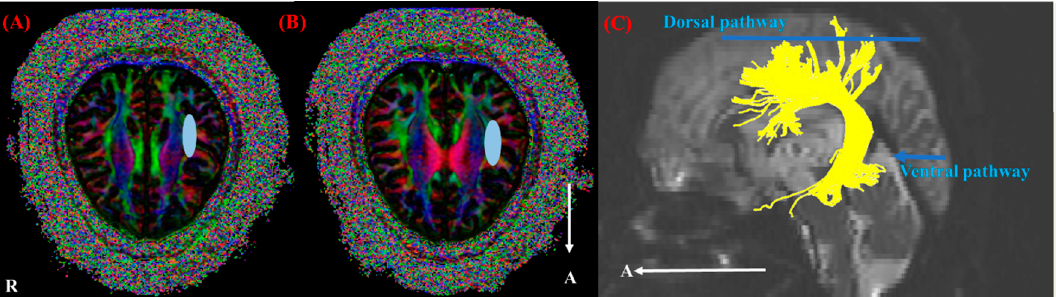
Figure 2. ( A ) “OR” region of interest (ROI) of the superior longitudinal fasciculus (SLF). ( B ) “AND” ROI of the SLF. ( C ) Reconstruction of the right SLF using diffusion tensor imaging (DTI) in a control subject (55 years, female). Note: yellow part; the right SLF, R, right; A, anterior; blue circle, ROI; blue line, dorsal pathway; blue arrow, ventral pathway.